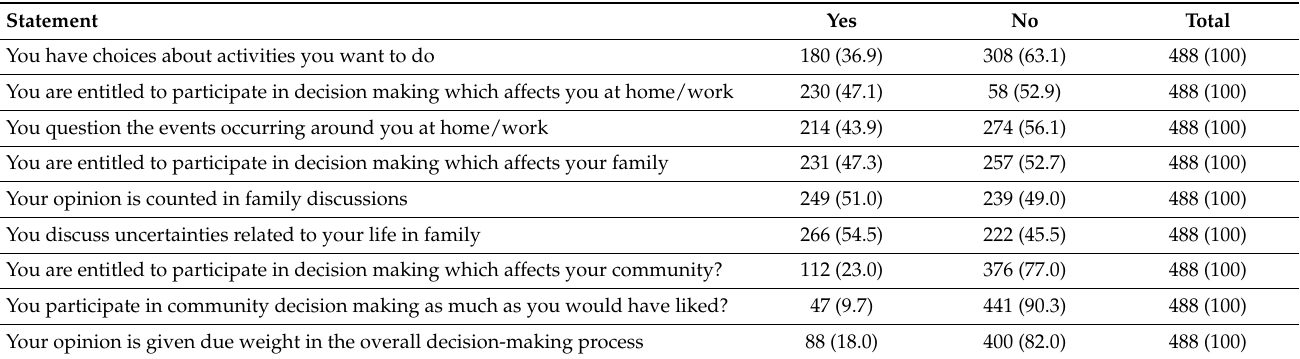
Table 2. Frequency distribution and proportion of respondents showing their participation in decision